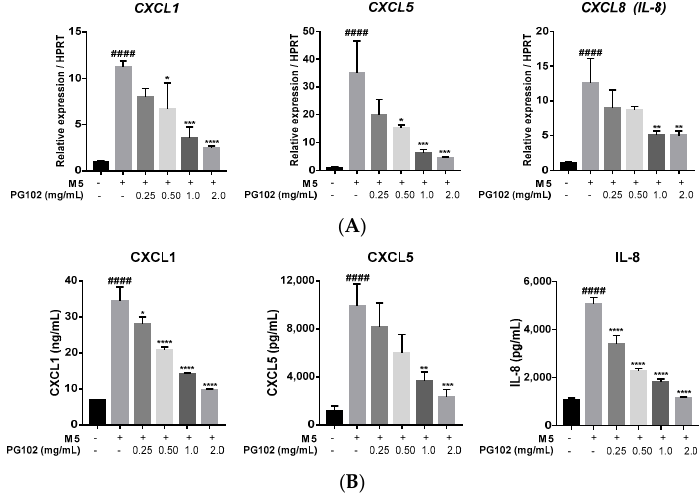
Figure 4. PG102 downregulates expression of chemokines on M5-stimulated HaCaT cells in a dose-dependent manner. ( A ) Real-time polymerase chain reaction (PCR) (qPCR) analysis of mRNA expression levels of chemokines after 6 h. ( B ) Protein levels of chemokines measured in the cultured supernatant by enzyme-linked immunosorbent assay (ELISA) after 24 h. CXCL, chemokine (C-X-C motif) ligand. #### p < 0.001 versus negative control group; * p < 0.05, ** p < 0.01, *** p < 0.001, **** p < 0.0001 versus M5-only treated